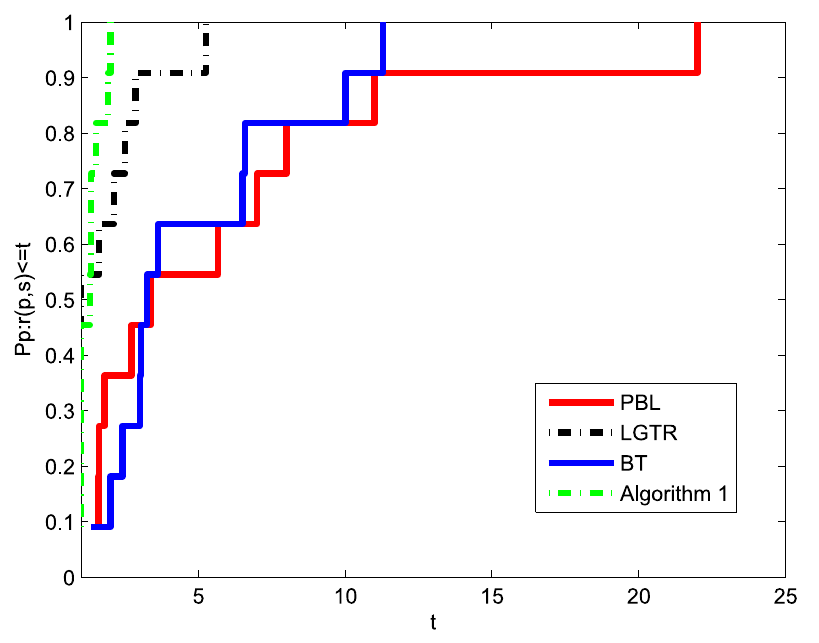
Fig 1. Performance profiles of these methods (NI).